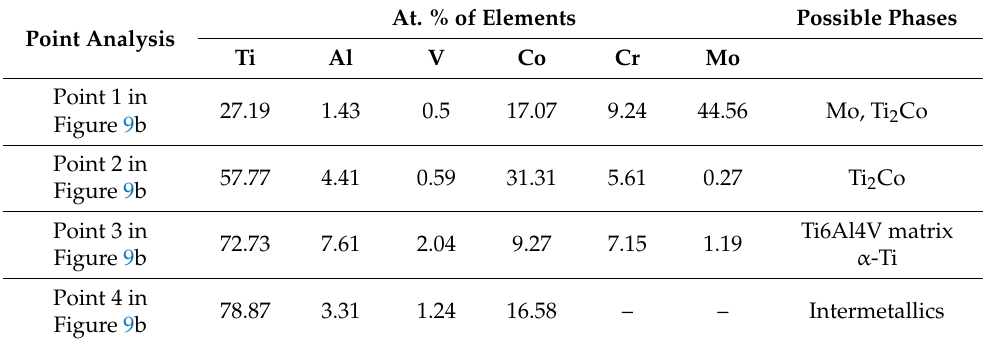
Figure 9. SEM BSE (back-scattered electron) micrographs of the sample containing 25 vol.% of CoCrMo: ( a ) area of black rectangle in Figure 7e; ( b ) interphase between a CoCrMo particle and Ti6Al4V; ( c ) precipitates at the boundaries of the eutectic phase. ( d – g ) are EDS elemental mapping of the composite containing 20% of CoCrMo particles. Table 3. EDS results of spot mode in Ti6Al4V–25 vol.% of CoCrMo sample after